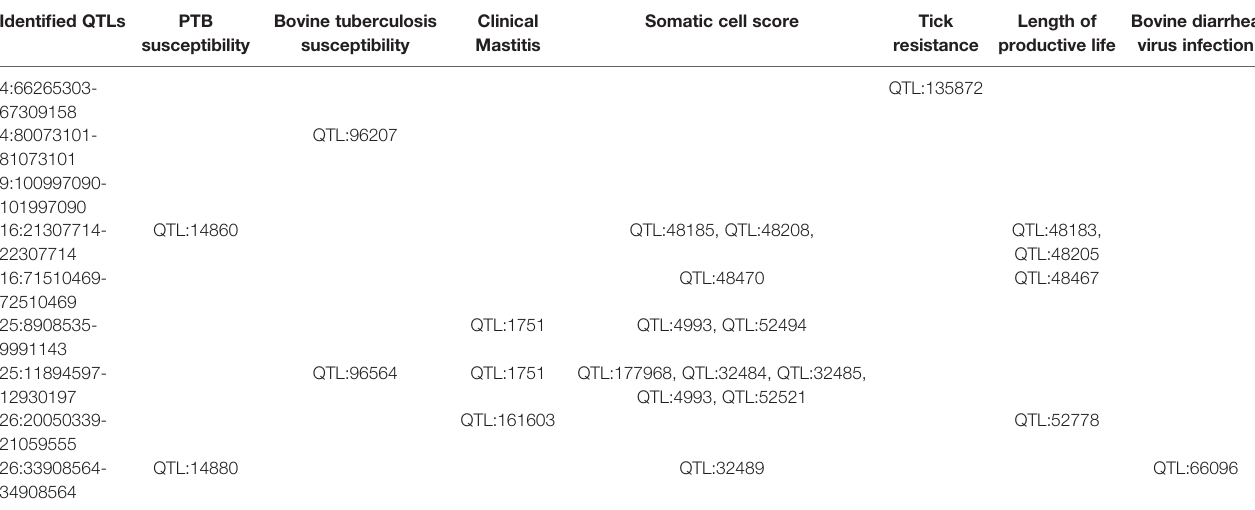
TABLE 4 | Overlapping of the identi fi ed QTLs with regions associated with other cattle diseases and relevant